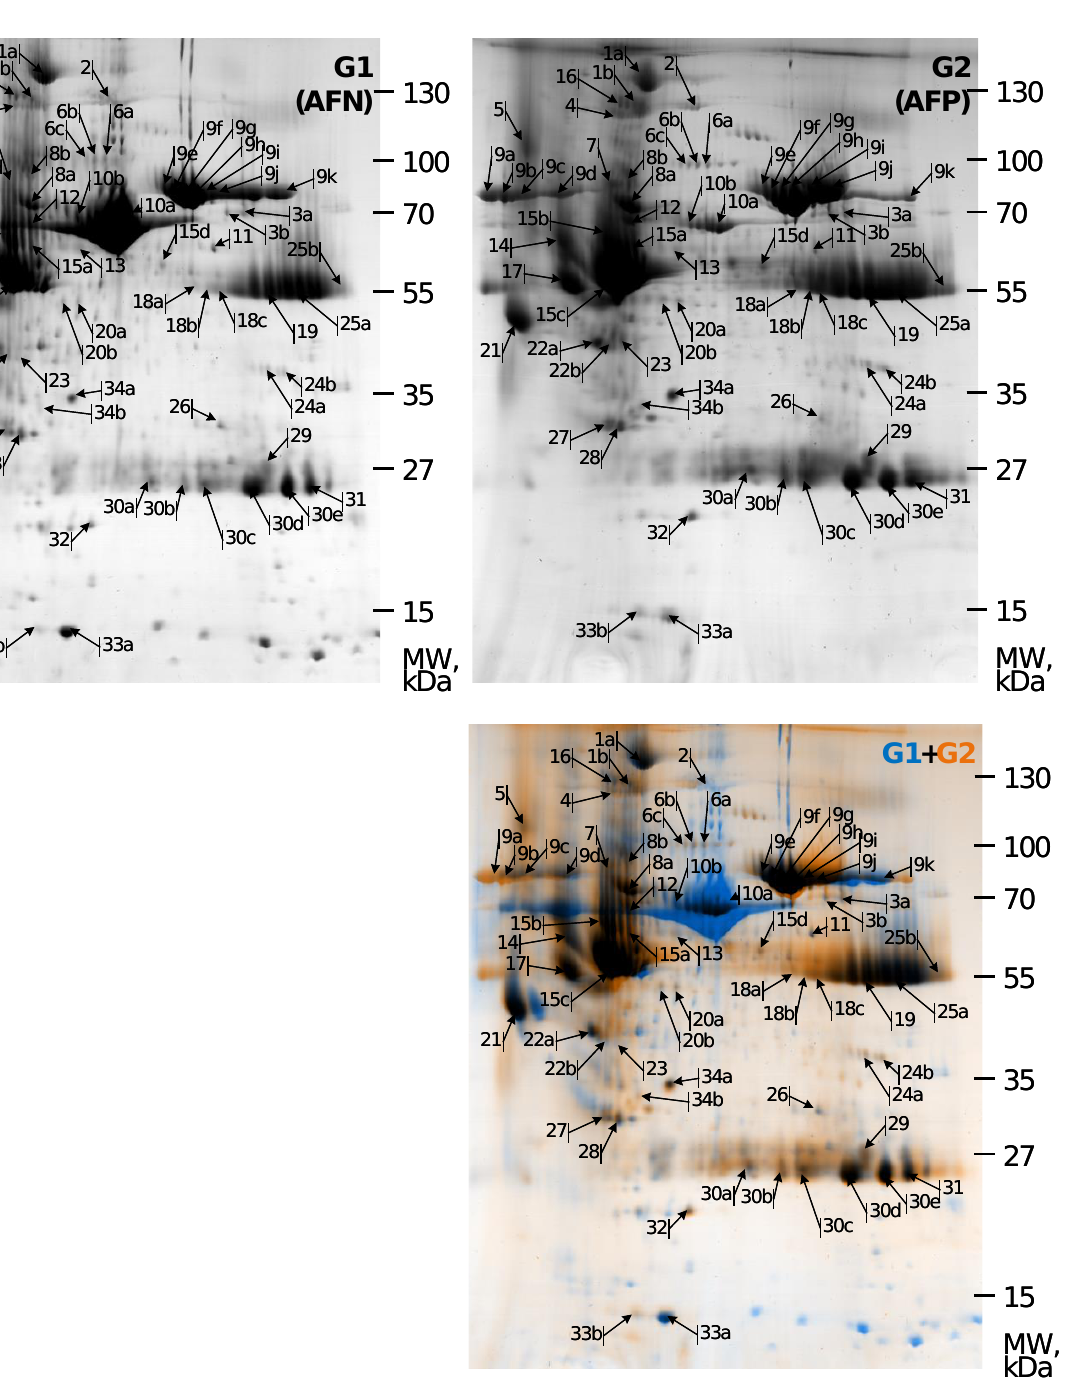
Figure 1. Comparative analysis of 2DE proteome maps characteristic for normal and polyhydramnios pregnancies. The proteins were resolved by 2DE, pH range 3–11, and Excel Gel SDS, gradient 8–18%. 2DE images of proteins of amniotic fluid of normal pregnancy (AFN, G1; blue in G1 + G2 and amniotic fluid of polyhydramnios pregnancy (AFP, G2; orange in G1 + G2) were superposed and presented in G1 + G2. Arrows and numbers in the 2DE maps indicate the positions of proteins supplied to MALDI-TOF MS/MS and identified. Spot labels are the same as in Table 1. Molecular weight (Mw) markers are presented on the left. Representative images from one of three experiments showing similar results are